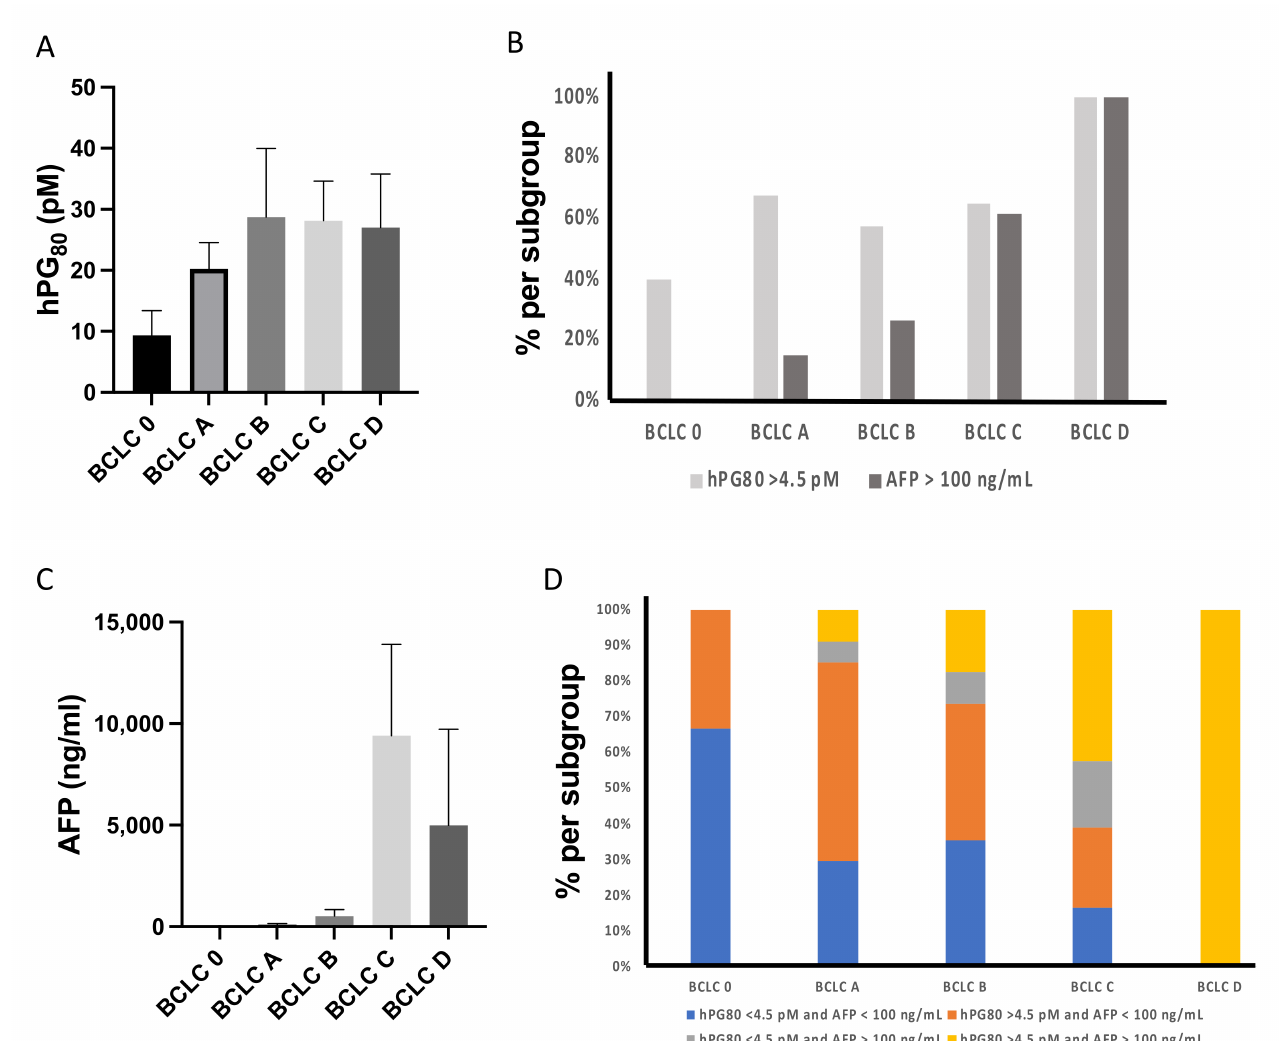
Figure 5. Detection rates for hPG 80 and AFP in HCC patients with different BCLC stages. ( A ) hPG 80 levels according to the BCLC stratification. ( B ) Percentage of HCC patients with high hPG 80 levels (hPG 80 > 4.5 pM) or high AFP levels (AFP > 100 ng/mL) according to BCLC stages. ( C ) AFP levels according to the BCLC stratification. ( D ) Percentage of HCC patients based on combined hPG 80 and AFP levels and according to BCLC